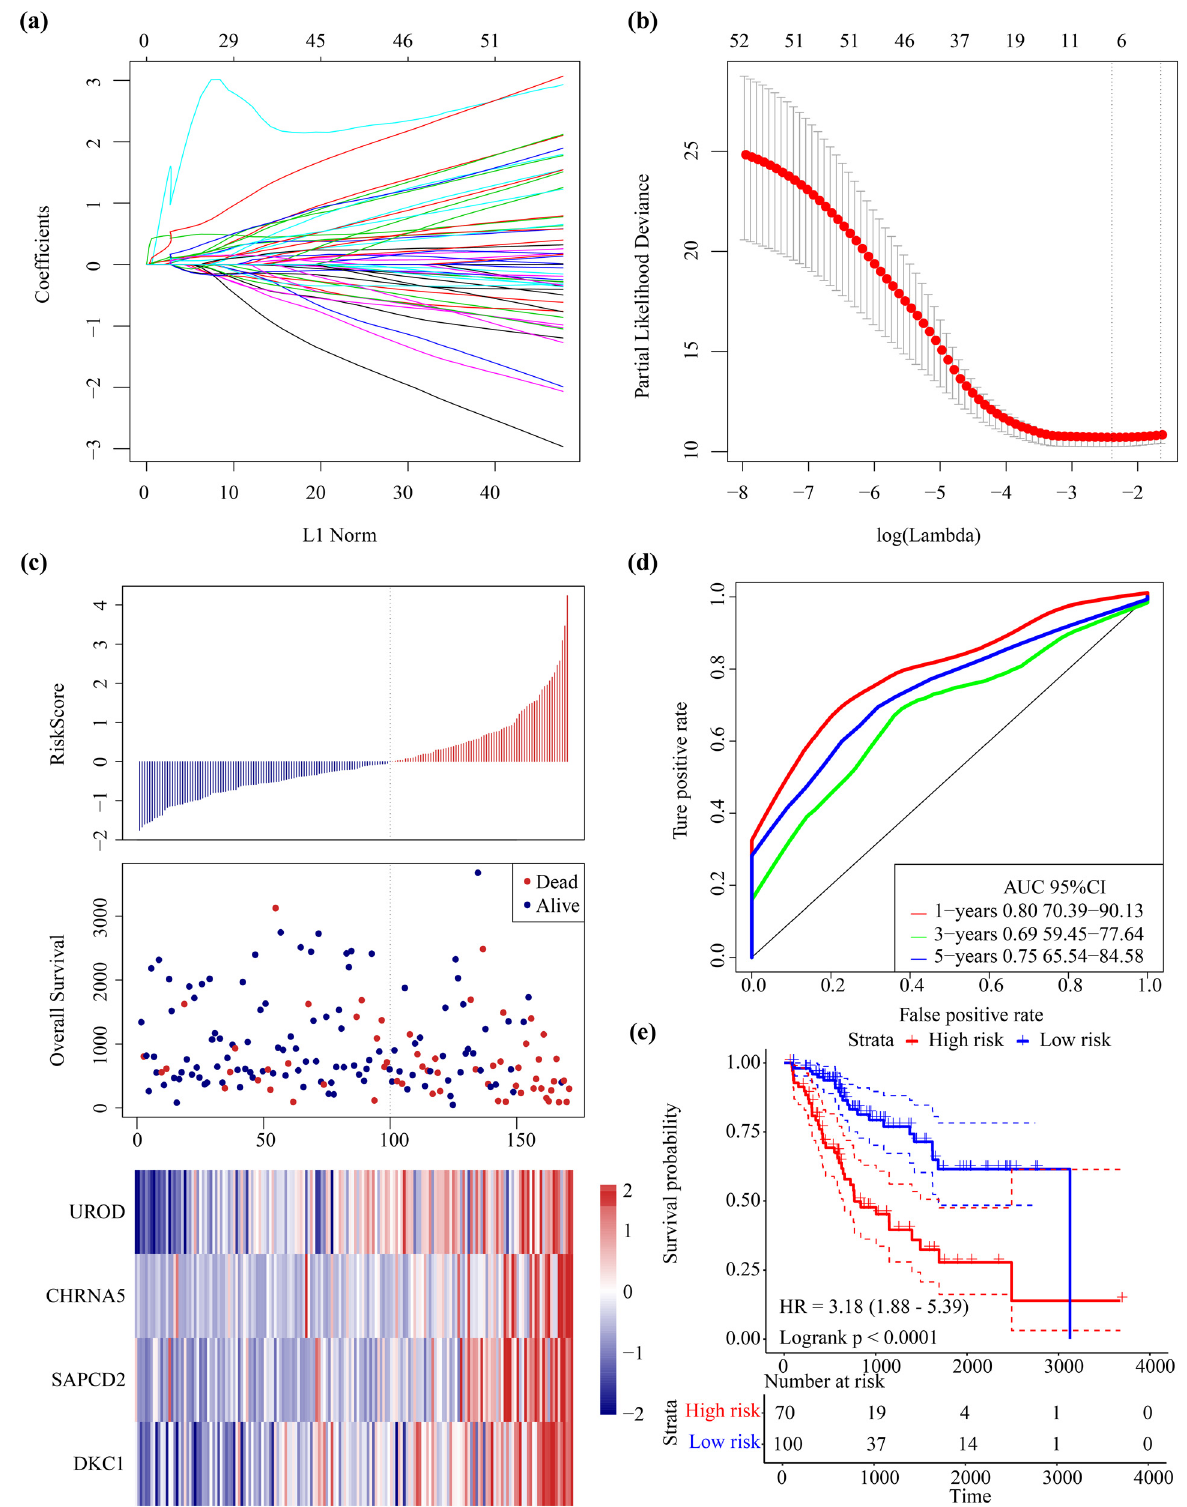
Figure 4: Identifying ceRNA associated four - gene signature for HCC survival: ( a ) the trajectory for each independent variable. The horizontal axis represents the log value of the independent variable lambda, and the vertical axis represents the coe ffi cient of the independent variable, ( b ) the con fi dence interval for each lambda, ( c ) risk score, survival time and survival status, and expressions of 4 - mRNAs in TCGA training set, ( d ) ROC curve and AUC of the 4 - mRNAs signature, and ( e ) KM survival curves distribution of 4 - mRNA signature in the TCGA training